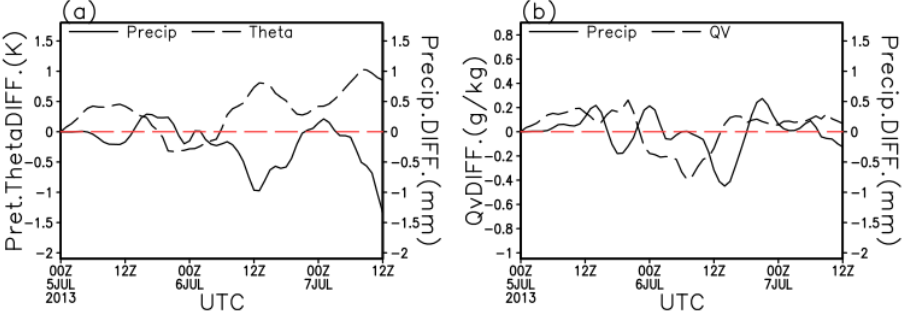
Figure 16. ( a ) Time series of precipitation differences (units: mm) and mean values of 0~1.5 km perturbed potential temperature differences (units: K) between the DP ensembles and the CTL experiment; ( b ) Time series of precipitation differences (units: mm) and mean values of 0~1.5 km water vapor mix ratio differences (units: g ⋅ kg −1 ) between the WP ensembles and the CTL experiment.